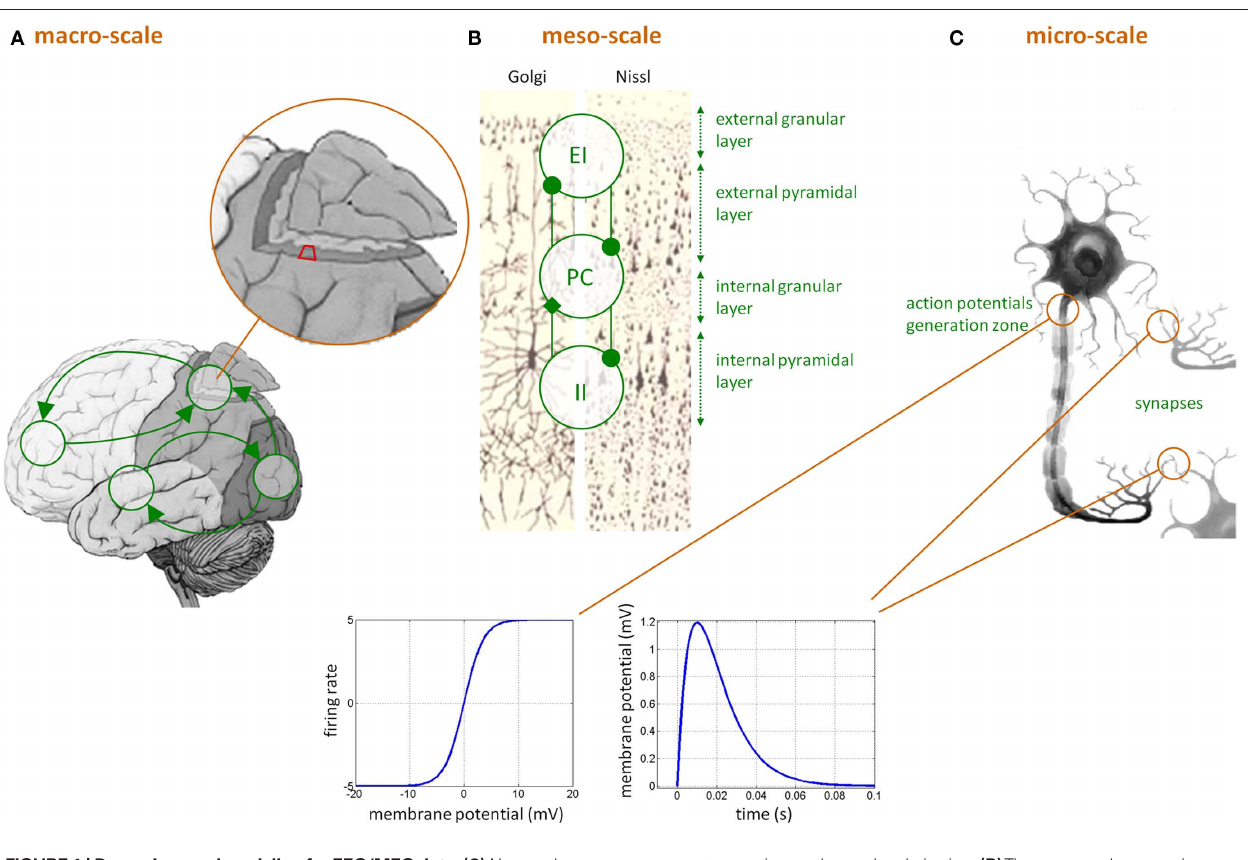
FiGurE 1 | Dynamic causal modeling for EEG/MEG data. (C) Neuronal features at the micro-scale that affect the level of the neural ensemble, i.e., at the meso-scale (B) : (i) sigmoidal transformation, describing how mean postsynaptic membrane potential is linked to mean presynaptic firing rate, and (ii) temporal convolution (kernel shown) of mean presynaptic firing rate yielding